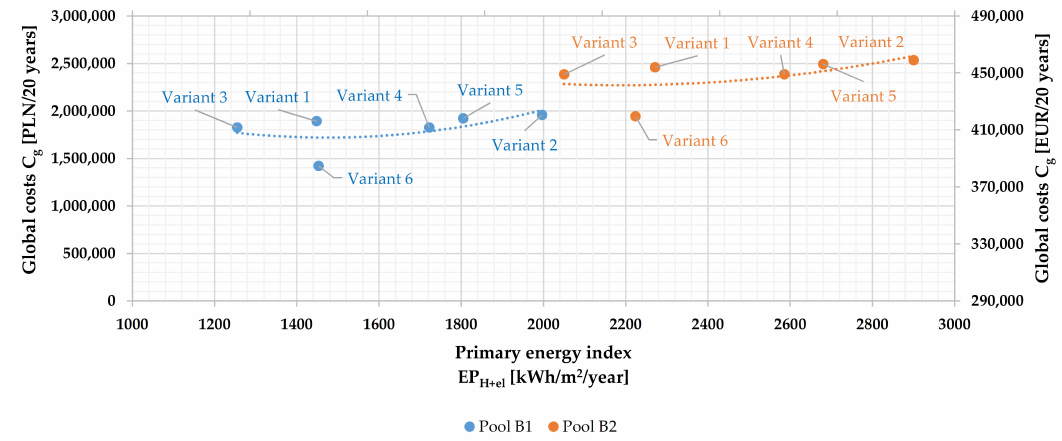
Figure 9. Global costs in function of primary energy index for pools with di ff erent